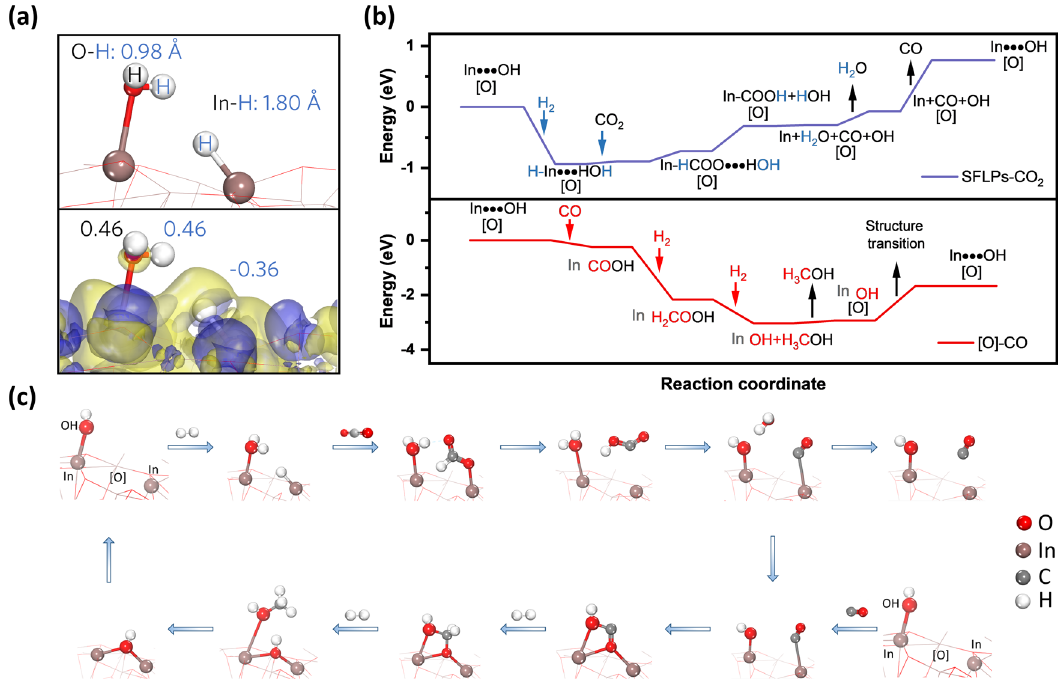
Fig. 4 DFT calculation for mechanism analysis. a Mulliken electronegativity analysis (Up) and corresponding differential charge density of protonated and hydridic SFLP sites (Down). b Free energy diagram of the RWGS reaction over SFLP sites and subsequent methanol synthesis over the [O] site. c The proposed tandem reaction mechanism for methanol synthesis and corresponding atomic con fi